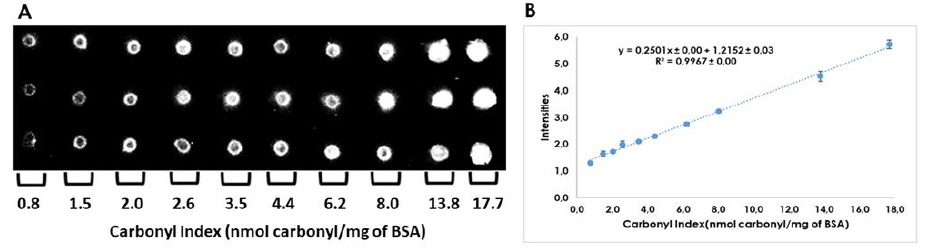
Figure 3. Calibration curve of carbonylated proteins for quantitation of carbonyl indexes by dot-blot. ( A ) . 2 μL of DNPH derivatized bovine serum albumin (BSA; 100 ng/μL) from standard working